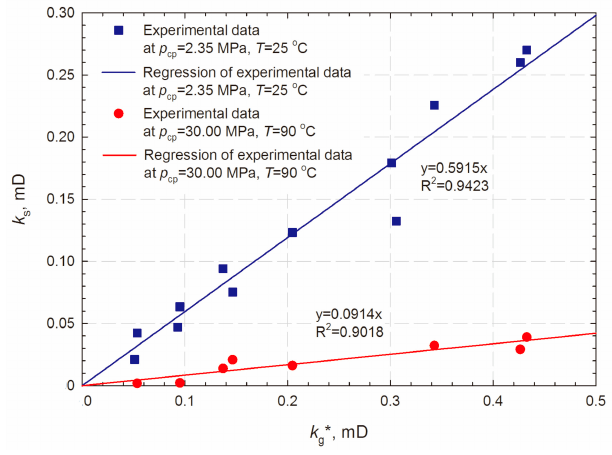
Figure 5. Correlations between the Klinkenberg permeability and (cid:1863) (cid:3034)∗ under different conditions.